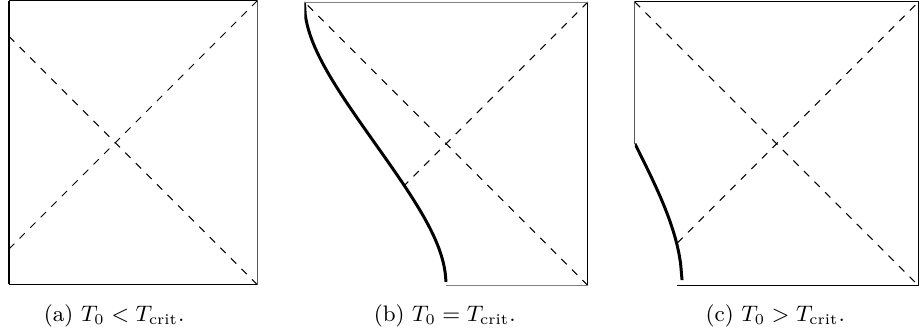
Figure 1 . Representative solutions for different values of the brane tension T 0